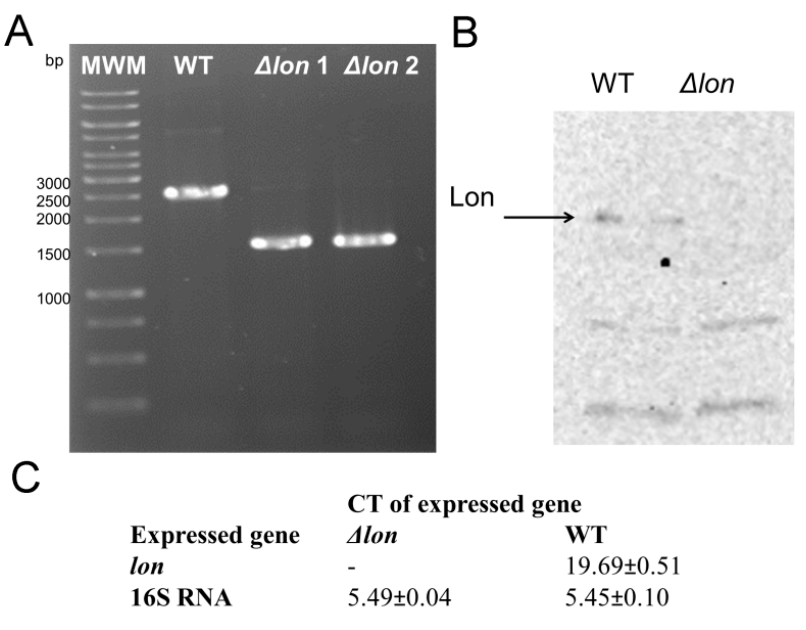
Figure 1. Confirmation of successful deletion of the lon gene in D. solani IPO 2222: ( A ) PCR analysis of genomic DNA isolated from the D. solani WT (wild type) and ∆ lon mutant. The lon gene was replaced by a 1000 bp smaller kanamycin resistance gene. ∆ lon1 and ∆ lon2 denote two independent clones ( B ) immunodetection using the anti-Lon E. coli primary antibodies. ( C ) The qPCR analysis with the use of the lon gene-specific primers revealed that no cDNA amplification product was created within 50 cycles.